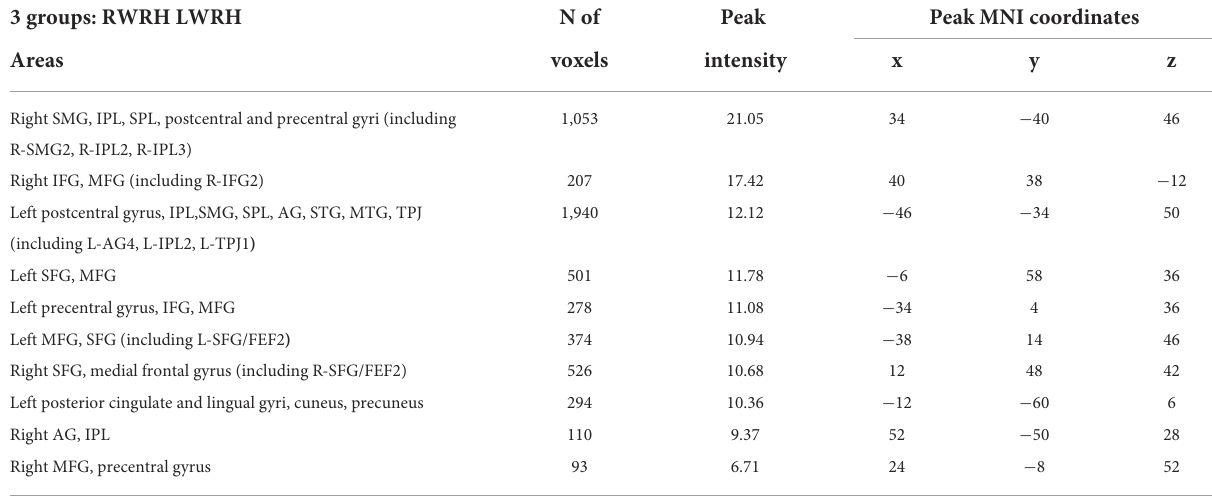
ActivationsaredisplayedinFigure3A.Regionsofinterest(spheresinFigures1–3)includedinthelistedclustersareindicatedinparentheses.AG,angulargyrus;FEF,frontaleyefield;IFG, inferior frontal gyrus; IPL, inferior parietal lobule; MFG, middle frontal gyrus; MNI, Montreal Neurological Institute; MTG, middle temporal gyrus; SFG, superior frontal gyrus; SMG, supramarginalgyrus;SPL,superiorparietallobule;STG,superiortemporalgyrus;TPJ,temporo-parietaljunction.